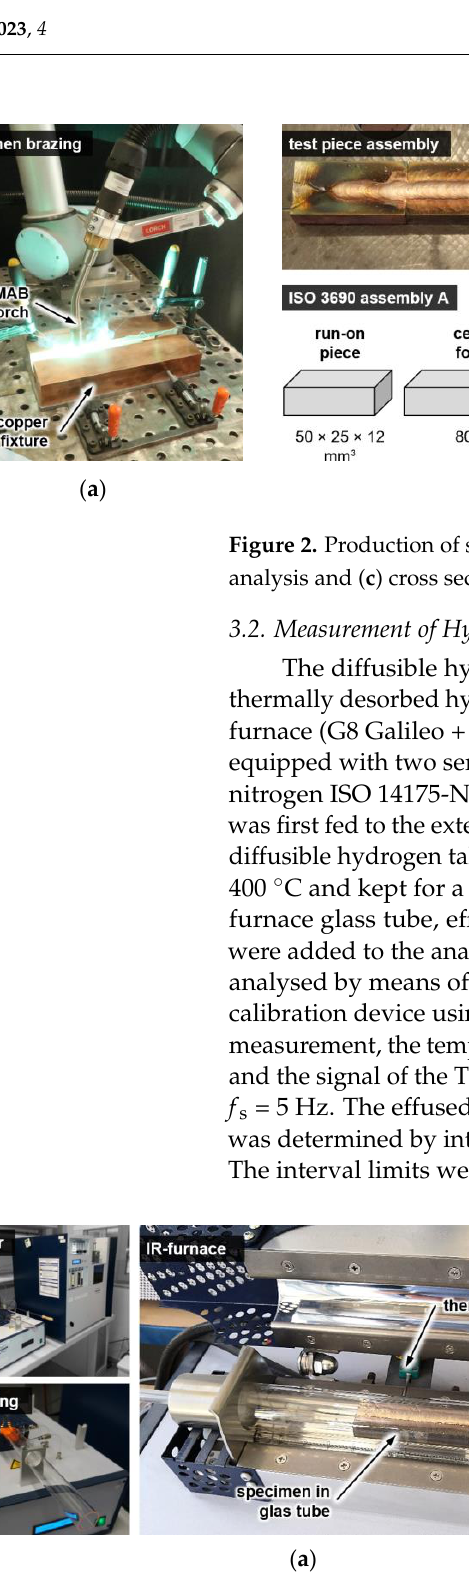
Figure 3. Measurement of hydrogen by carrier gas hot extraction using thermal conductivity detector method; ( a ) test specimen in IR-furnace for degassing; ( b ) signal course during thermal desorption